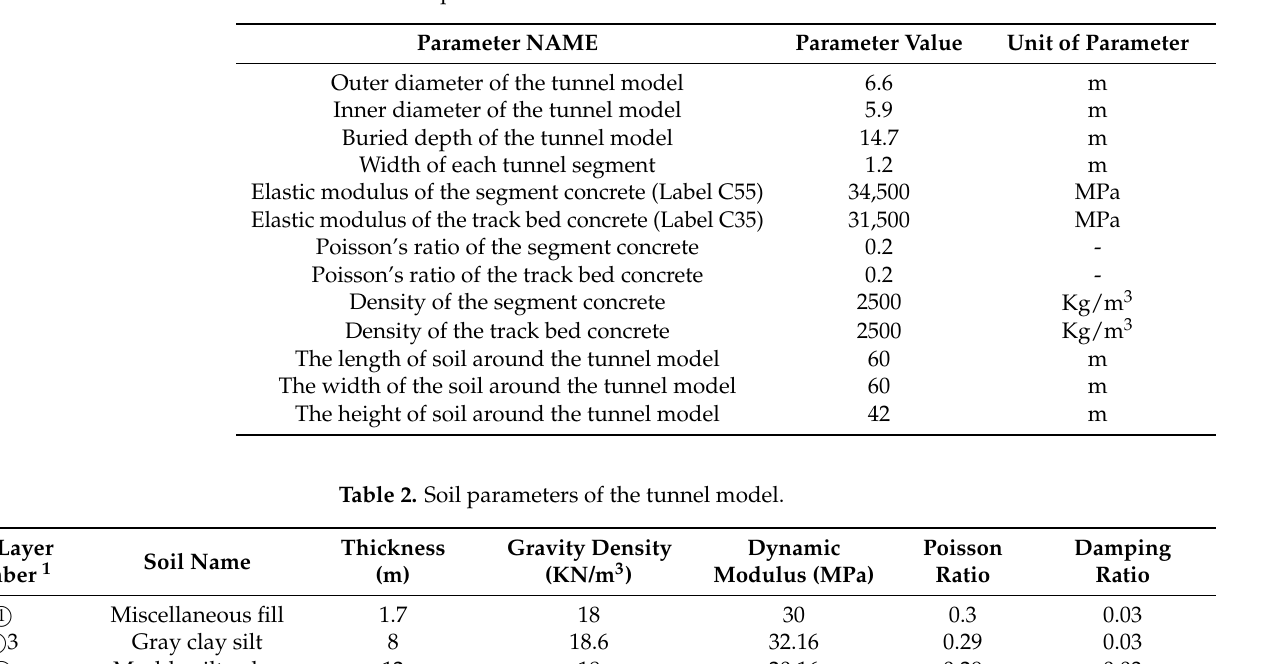
Table 1. Calculation parameters of 3D tunnel and soil model.